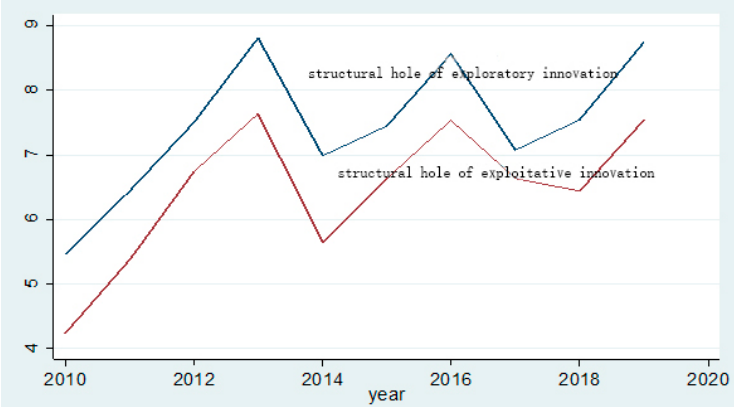
Figure 9. Change curve of the structural hole based on dual innovation strategy .